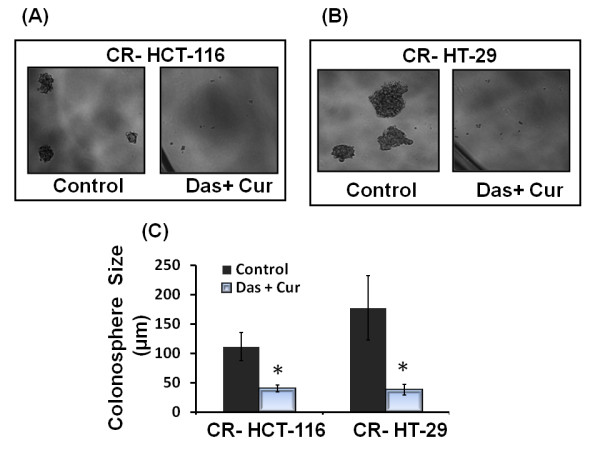
Representative photograph showing formation of colonospheres by (A) CR HCT-116 and (B) CR HT-29 cells after incubating with dasatinib(1 μM), and curcumin (10 μM). Average size of colonospheres formed by CR HCT-116 and CR HT-29 in response to the combination therapy (C). The controls were incubated with FOLFOX (50 μM 5-FU + 1.25 μM oxaliplatin) containing medium only. *P < 0.01, compared with the corresponding control.